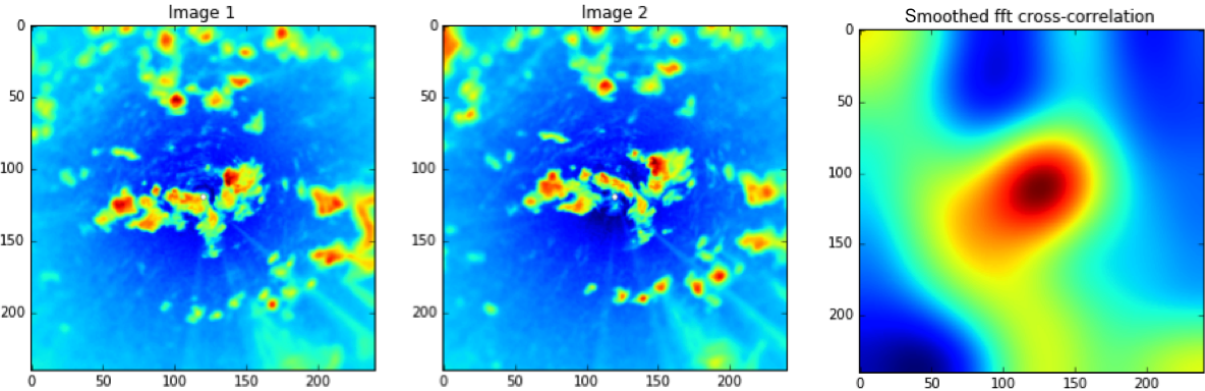
Figure 2. Two reflectivity factor snapshots (gridded to a constant height of 1km) from subsequent NEXRAD scans of KHGX and their cross-correlation. The peak in the cross-correlation gives a good indication of the image shift between the two time steps and is used as the position start of the search to identify cells in subsequent